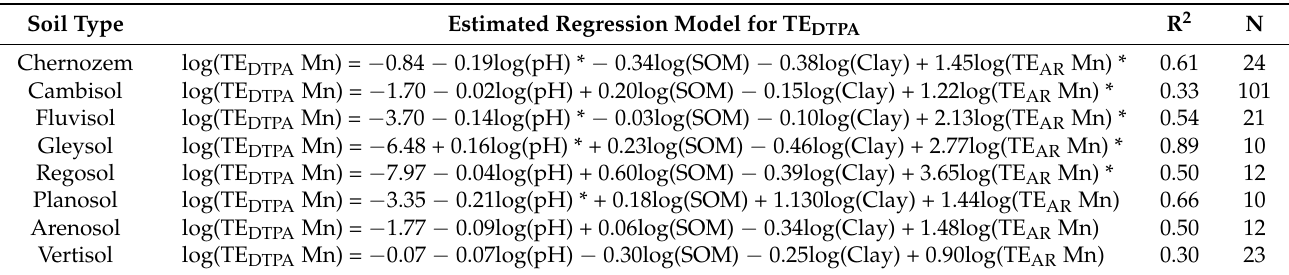
Table 6. Prediction model